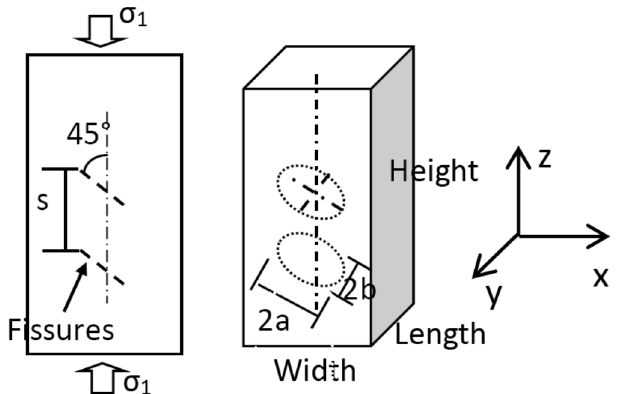
Figure 5. Location of double parallel